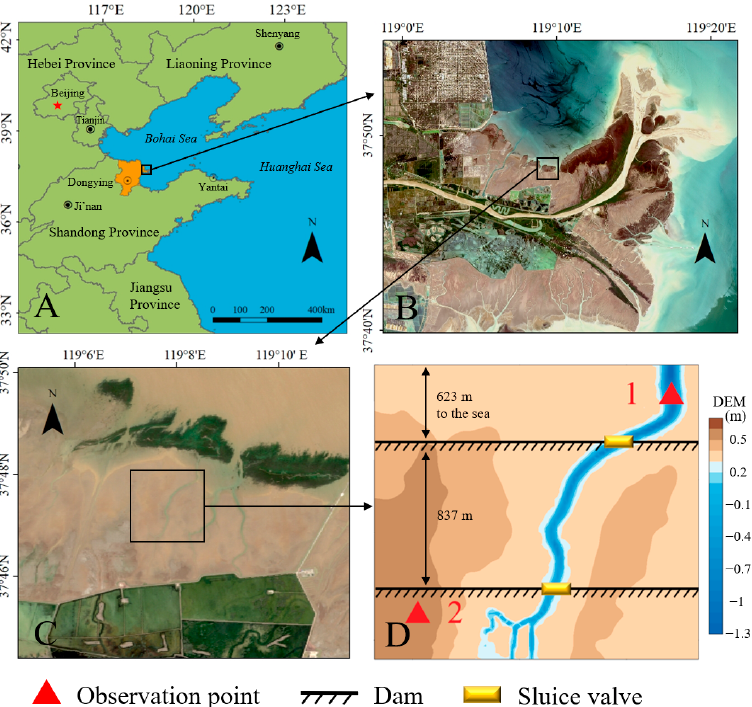
Figure 1. The location of study area and experimental design. ( A ) means the location of Dongying City, Shandong Province. ( B ) means the location of Yellow River Delta. ( C ) means the location of study area. ( D ) means the experimental design.